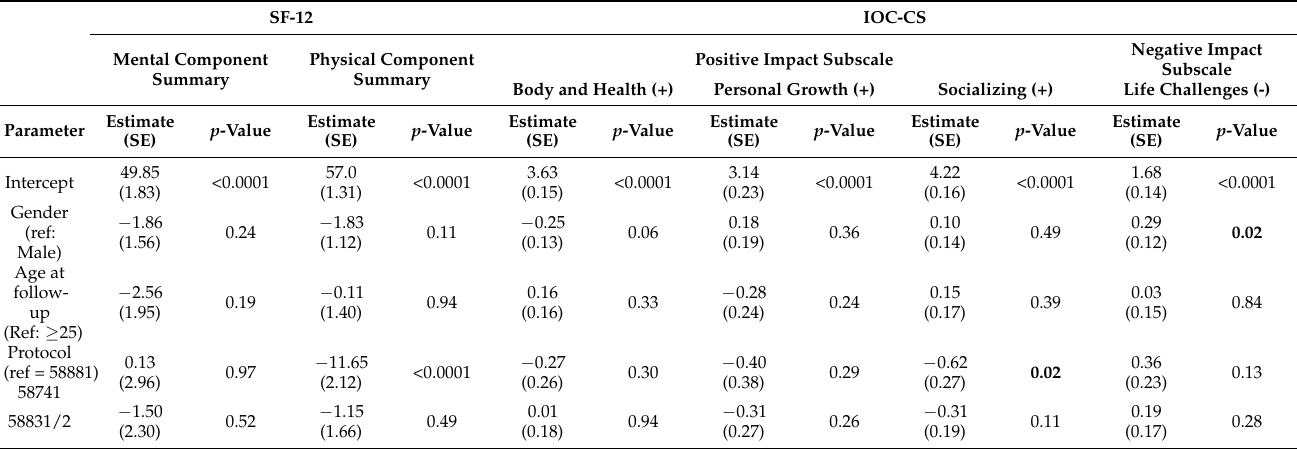
Table 2. Associations between gender and SF-12 subscales and IOC-CS subscales based on a multi- variable regression analysis.